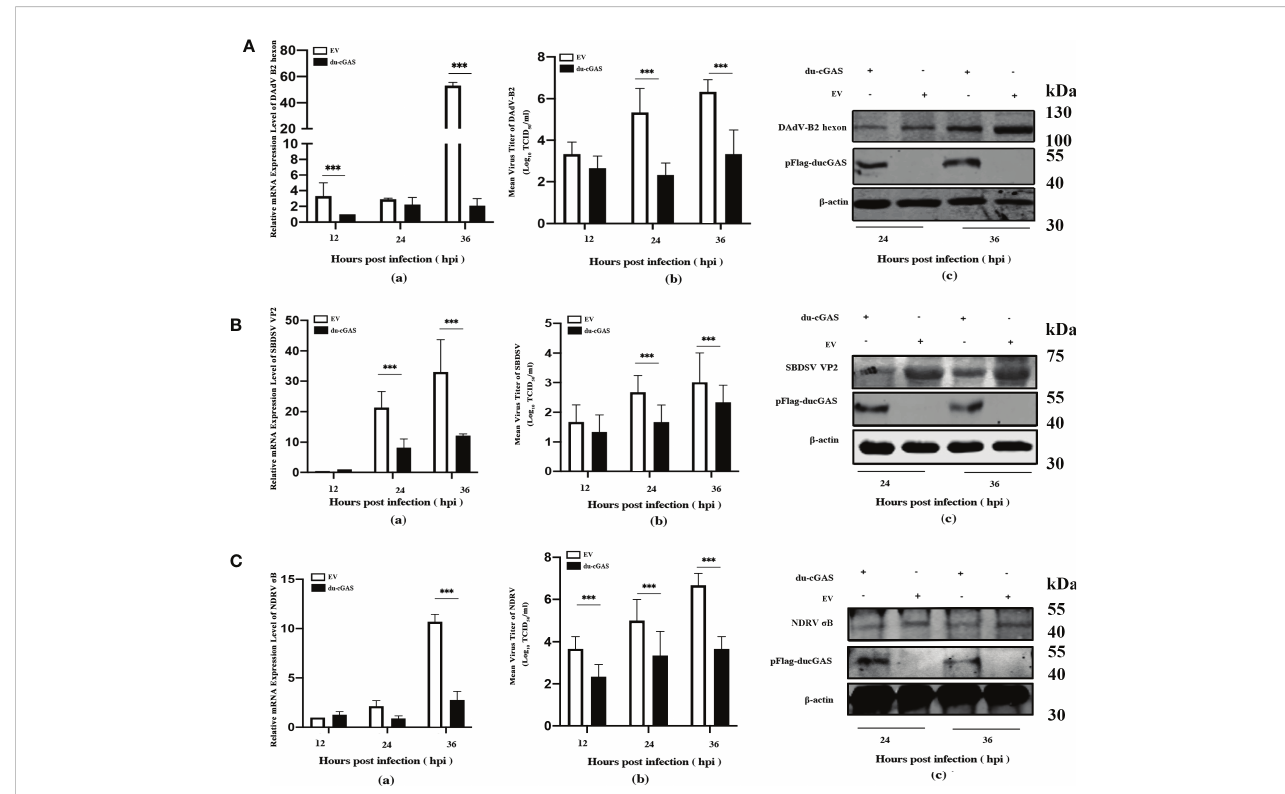
FIGURE 5 Du-cGAS overexpression inhibited both DNA and RNA viruses ’ replication. DEF cells expressing du-cGAS and EV were infected with DAdV-B2, SBDSV and NDRV at the MOI of 1.0 and harvested at indicated time points (12, 24, and 36 hpi). The relative mRNA expression levels of viral genes in the infected DEF cells were determined by qRT-PCR, and the viral titers in the cell culture supernatant were detected by TCID 50 assay. The viral protein expression levels in infected DEF cells were detected by western blotting. (A) DAdV-B2 infection. (B) SBDSV infection. (C) NDRV infection. Data represent the mean values ± SD, and statistical signi fi cance was analyzed by t-test. * P < 0.05, ** P < 0.01, *** P <